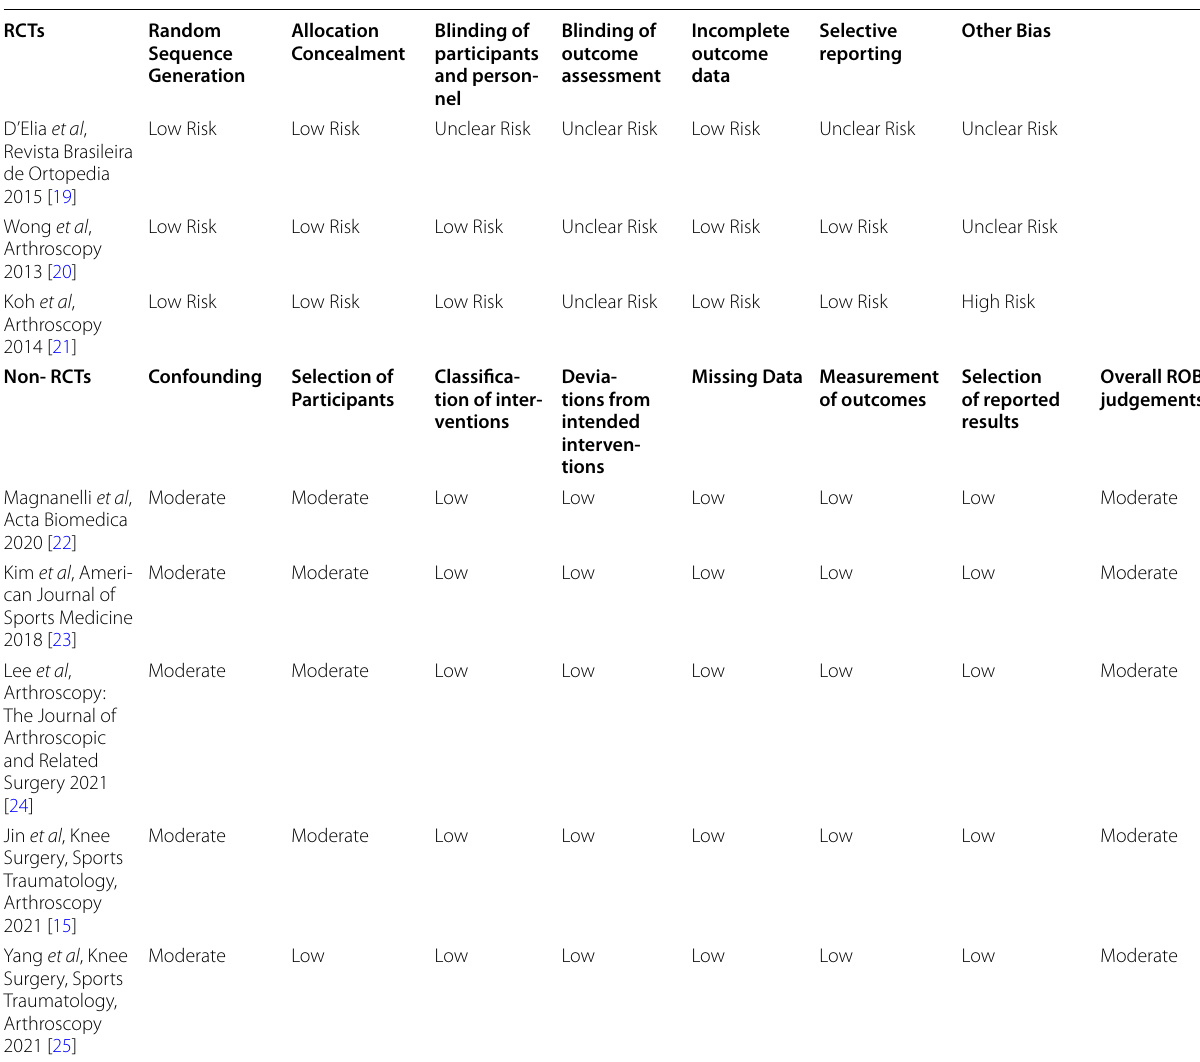
Table 1 Risk of bias in included studies